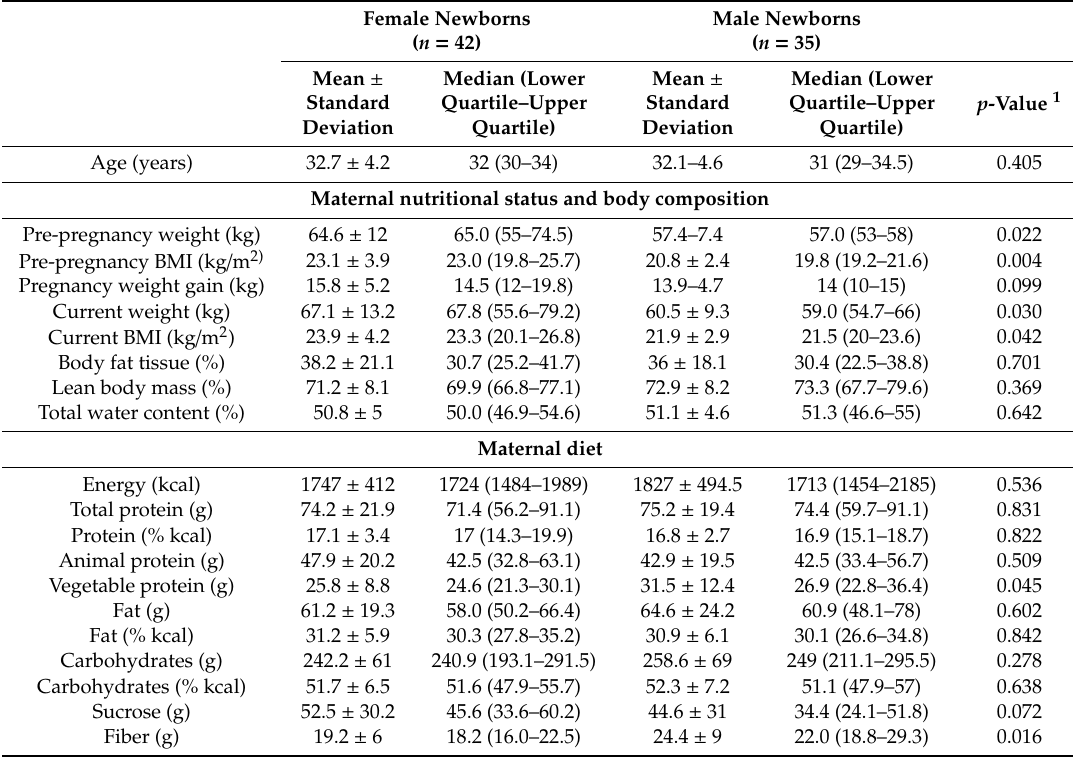
Table 2. Comparison of mothers according to newborn’s sex.